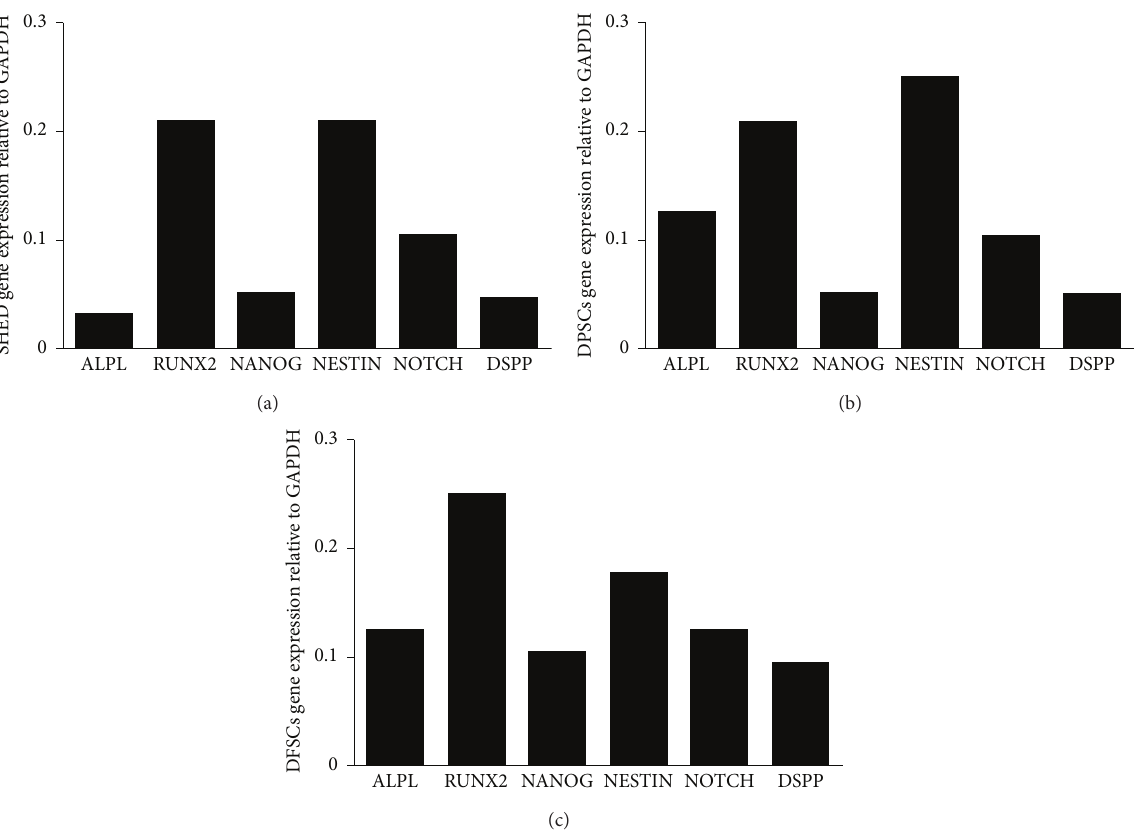
Figure 4: Gene expression of specific markers for SHED (a), DPSCs (b), and DFSCs (c), including ALPL (alkaline phosphatase), RUNX2 (runt-related transcription factor 2), NANOG, NESTIN, NOTCH, and DSPP (dentin sialophosphoprotein) according to housekeeping gene GAPDH (glyceraldehyde 3-phosphate dehydrogenase) was performed.